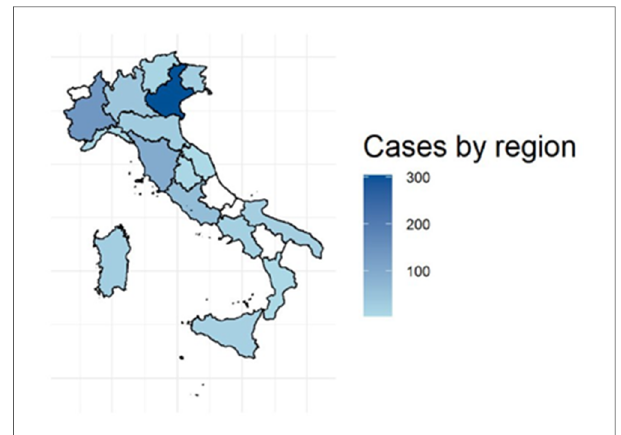
FIGURE 2 Map of Italy, showing the number of enrolled cases for each region. Shades of blue re fl ect the activity of a speci fi c region. Regions in white are not actively contributing to the RITI registry activity at the present